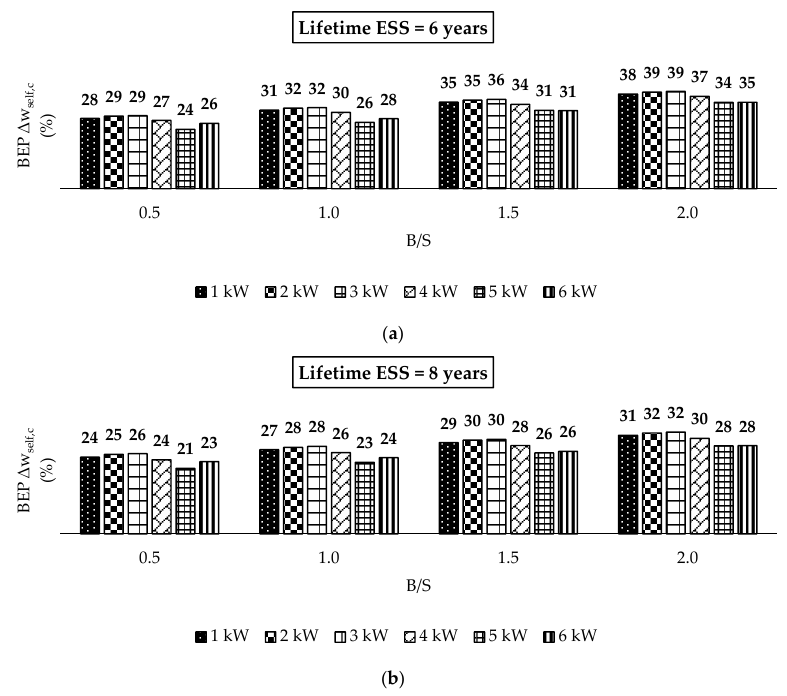
Figure 3. Net Present Value (PV + ESS)/Size (€/kW) with B/S equal to 2.0. ( a ) is expressed in €/kW with B/S equal to 2.0 and lifetime EES equal to six years; ( b ) is expressed in €/kW with B/S equal to 2.0 and lifetime EES equal to 8 years.